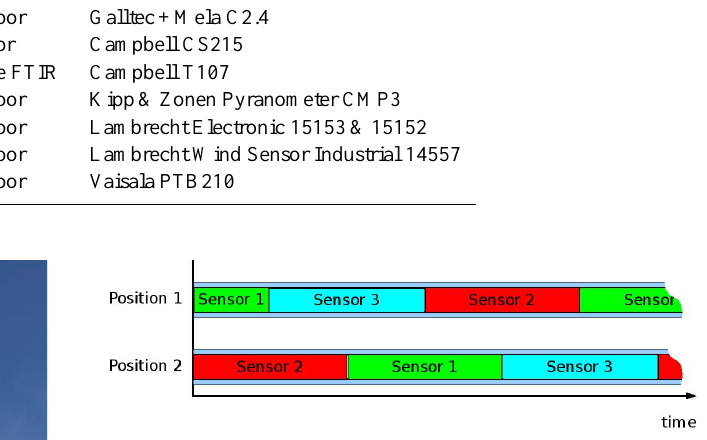
Fig. 6. Pressure sensor recalibration scheme. Sensors 1 and 2 are used for redundant measurements while sensor number 3 is a cali- brated spare that replaces one of the two used sensors (e.g. sensor 1) at the next maintenance after aproximately 6 months. Sensor 1 will then be recalibrated and later replace sensor